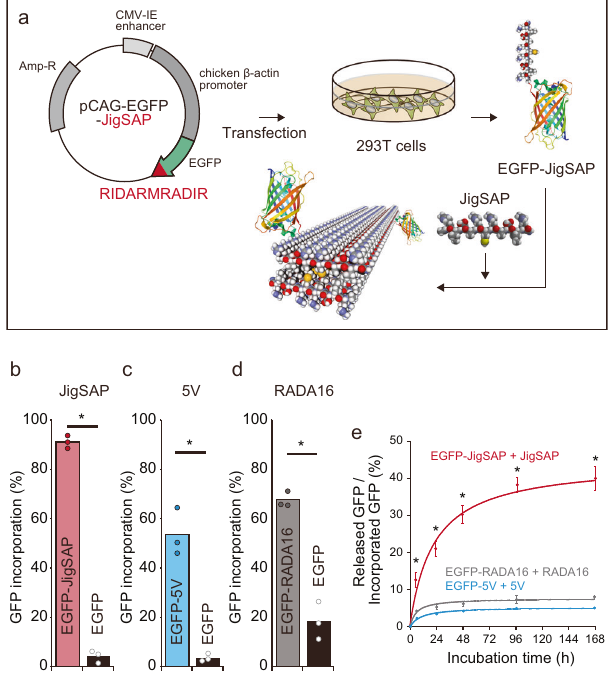
Fig. 2 Ef fi cient incorporation and sustained-release of JigSAP-tagged EGFP protein. a , Experimental design: the sequence encoding the JigSAP peptide was attached to the C-terminal of EGFP cDNA. EGFP-JigSAP-expressing plasmids were transfected into 293T cells. Partially puri fi ed EGFP-JigSAP proteins were incubated with JigSAP peptides. Ribbon diagram showing the EGFP structure was obtained from PDB 2Y0G. b – d The incorporation ratios of peptide-tagged and non-tagged EGFPs. EGFP-JigSAP ( b , red), EGFP-5V ( c , blue), and EGFP-RADA16 ( d , gray) were incorporated into JigSAP, 5V, and RADA16 peptide nano fi bers, respectively. Non-tagged EGFP ( b - d , black) was used as a control. Protein incorporation (%) = [(weight of input) – (weight of the soluble fraction)] / (weight of input) × 100 (%). n = 3. e The ratios of released GFP to incorporated GFP. EGFP-JigSAP (red), EGFP-5V (blue), and EGFP-RADA16 (gray) were released from JigSAP, 5V, and RADA16 peptide nano fi bers, respectively. Released protein / incorporated protein (%) = (total weight of the soluble fraction) / (weight of incorporated protein) × 100 (%). n = 3. * P <0.05 (Student ’ s t -test against EGFP ( b – d ) and EGFP- RADA16 + RADA16 and EGFP-5V + 5V ( e ), two-sided). Data are mean±SEM. Source data are provided as a Source Data fi le. Abbreviations; Amp-R (ampicillin resistant gene), CMV-IE (cytomegalovirus immediate early), EGFP (enhanced green fl uorescent protein), JigSAP (jigsaw-shaped self- assembling